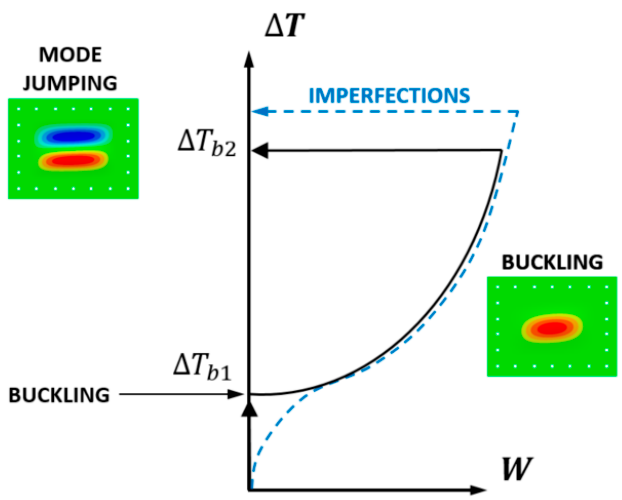
Figure 2. Thermal equilibrium path of a post-buckled composite plate.